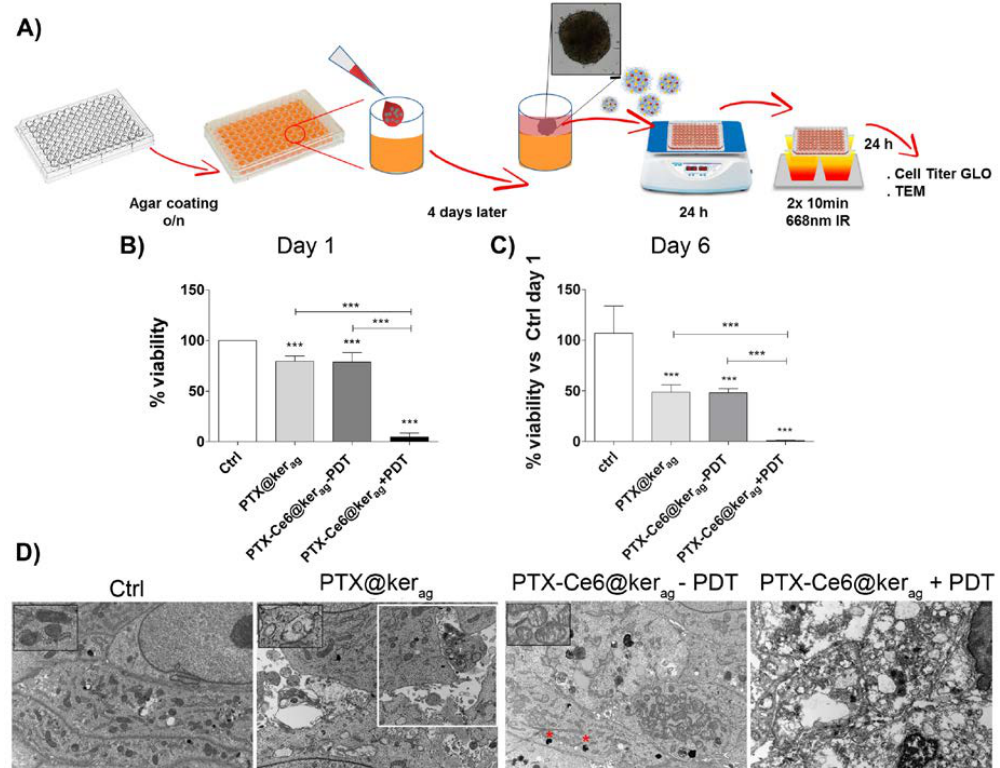
Figure 6. Impact of keratin nanoformulation on 3D OS tumor model. ( A ) Schematic representation of cell spheroid formation and treatment with PTX-Ce6@ker ag at a [Ce6] concentration of 6.7 µ M; ( B , C ) the graphs show the Cell Titer Glo assay performed 1 day ( B ) or 6 days ( C ) after keratin nanoparticle treatment and − /+ irradiation ( − /+PDT). The results are normalized to Ctrl at day 1 (no treated cells) and expressed as mean ± SD (N = 6 technical replicates and N = 2 individual replicates experiments) using the one-way ANOVA test, and Tukey’s multiple comparison test as a post-test. Results were considered to be statistically significant at p values < 0.05. * p -values < 0.05, ** p -values < 0.01 and *** p -values < 0.001; ( D ) transmission electron microscopy of treated MG63 spheroids with PTX@ker ag and PTX-Ce6@ker ag one day after irradiation (+PDT). The black squares highlight the mitocondrial alterations after nanoparticle treatment, compared to Ctrl spheroids. The white square in PTX@ker ag highlights the necrosis area, and the red star in PTX-Ce6@ker ag -PDT highlights the vesicle containing semidigested keratin nanoparticles. Scale bar: 2 µ